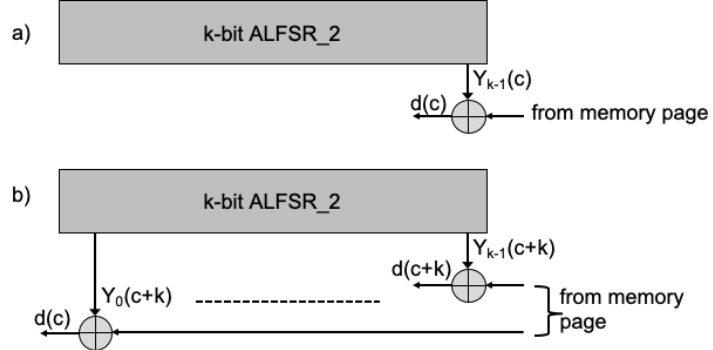
Figure 9. Possible schemes used to reconstruct data read from a memory page. ( a ) At any clock cycle c the read data is XORed with the last register bit Y k − 1 ( c ) to provide d ( c ) ; ( b ) k clock pulses are applied to ALFSR 2 , then the register content is XORed with k data read and the procedure is repeated until all page data are